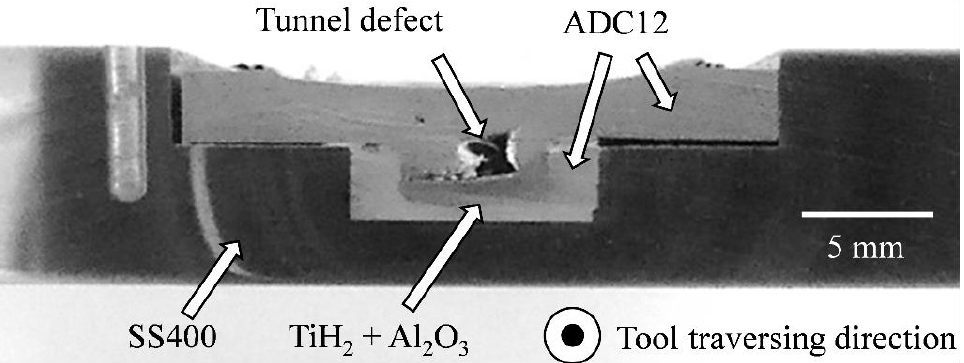
Figure 7. Enlarged cross section of precursor at v = 10 mm/min.